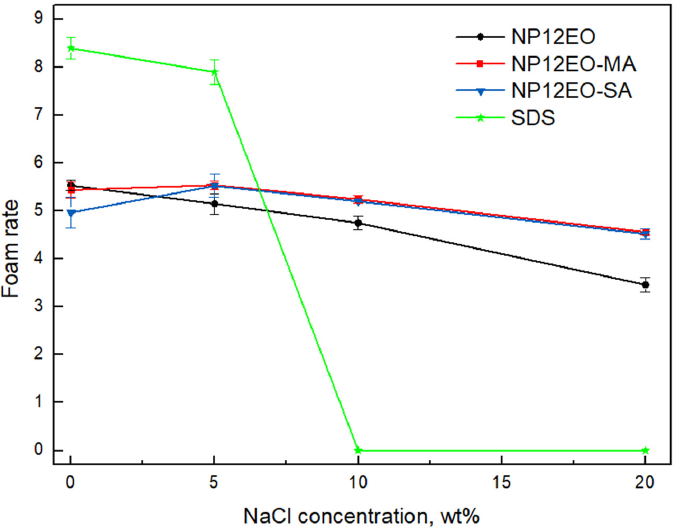
Figure 3. Foam rate of surfactants at 0, 5, 10, and 20 wt% of NaCl concentrations.